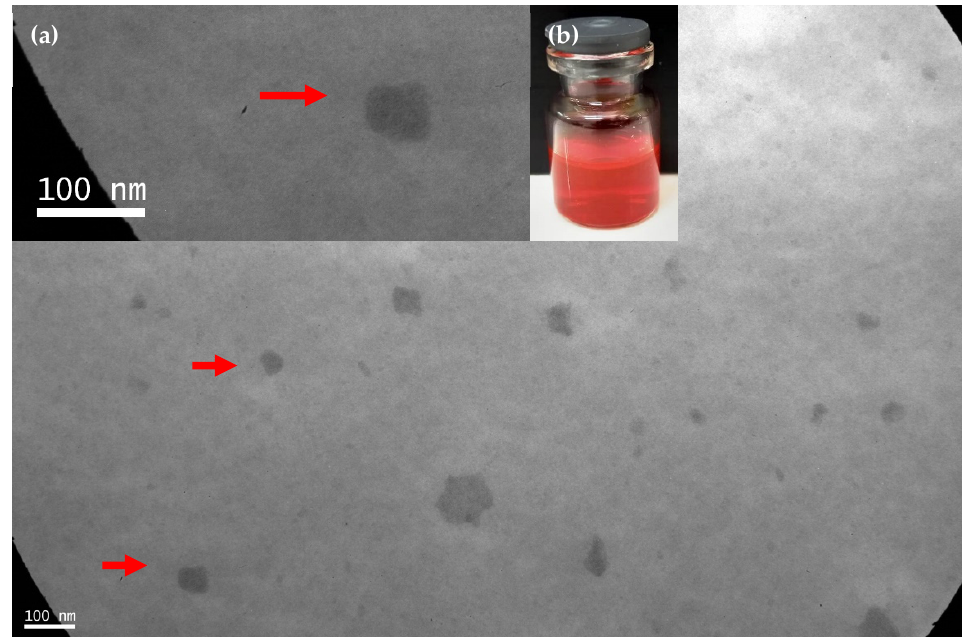
Figure 3. TEM micrograph of RIF–CUR (10 mg/mL and 5 mg/mL)-(man)(0.7% w / v )-micelles (10% w / v ). Red arrows point out the polymeric micelles. Scale bar: 100 nm. Photo Inset: ( a ) Magnification of TEM micrograph and ( b ) macroscopic aspect of the drug-loaded micellar dispersion after re-dispersion in distilled water. Table 2. Micellar size and size distribution (PDI) of free and drug-loaded Solupus micelles (10% w / v ) with and without mannose at 25 °C, before and after lyophilization. Data are expressed as mean ± S.D. (n = 5).